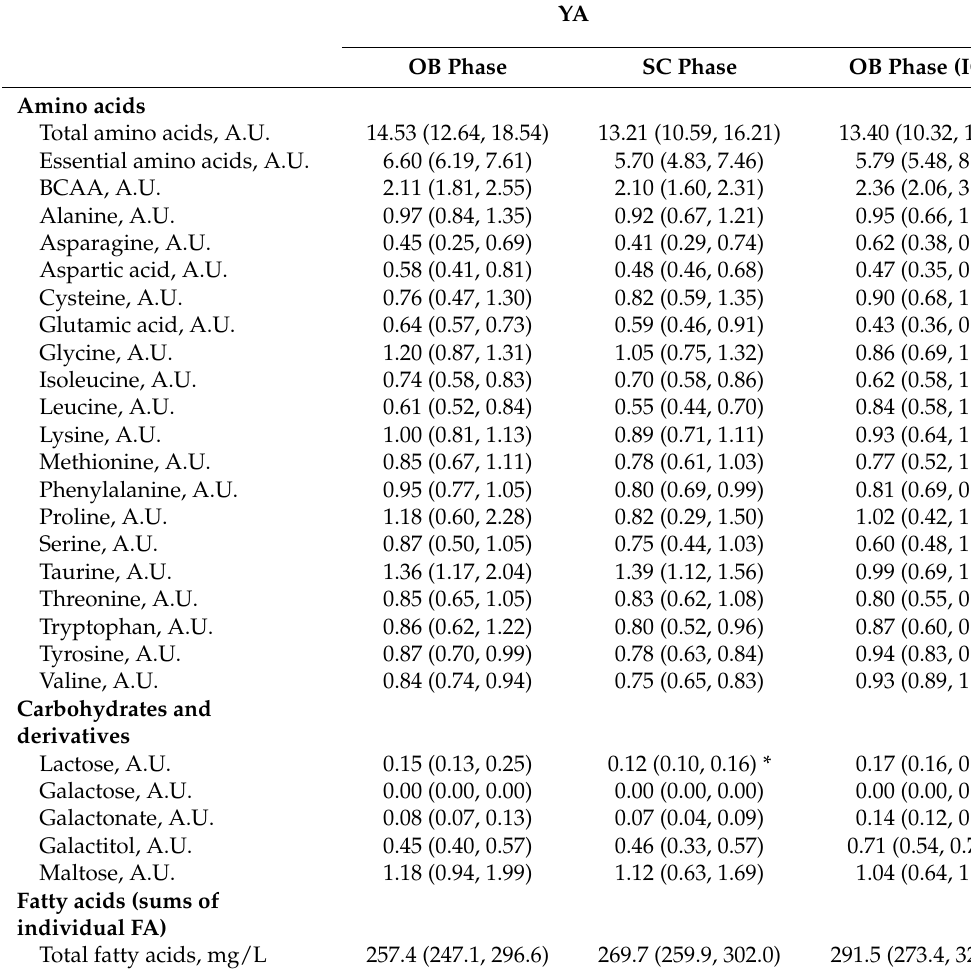
Age Effect Diet Effect Interaction